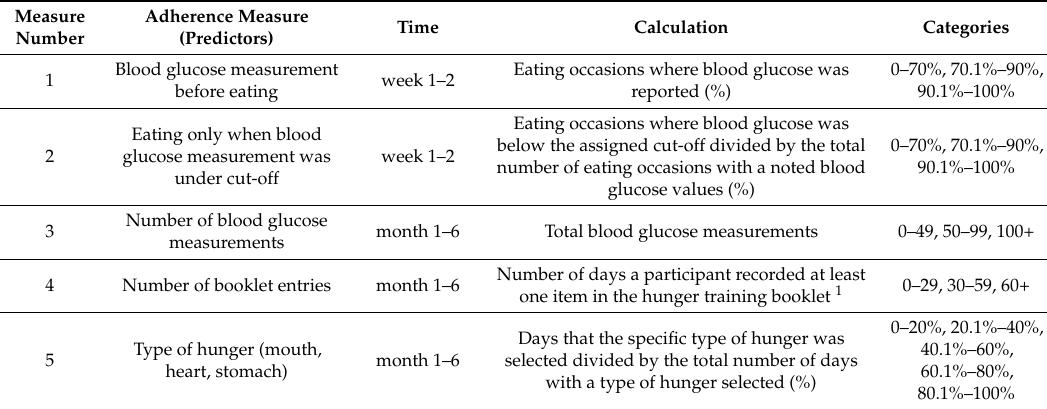
Table 1. Adherence measures used as predictors in hunger